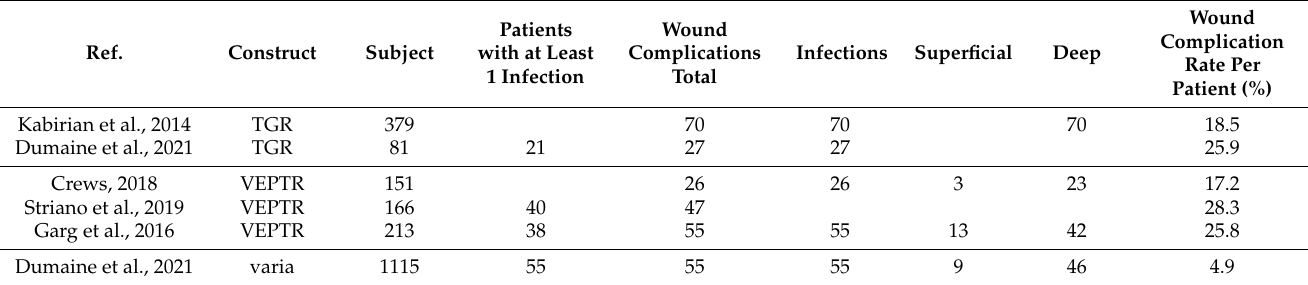
Table 3. Number of wound complications in extracted papers where only SSI was